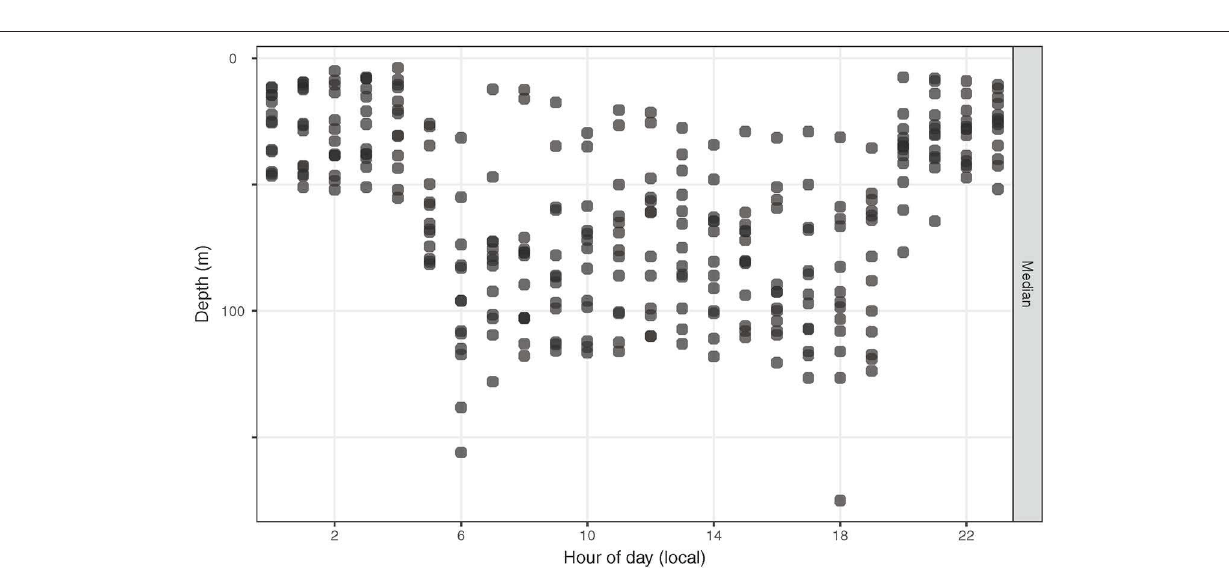
FIGURE 3 | Hourly median depths of tagged yellowfin tuna. For each fish, depths were summarized hourly over its entire time at